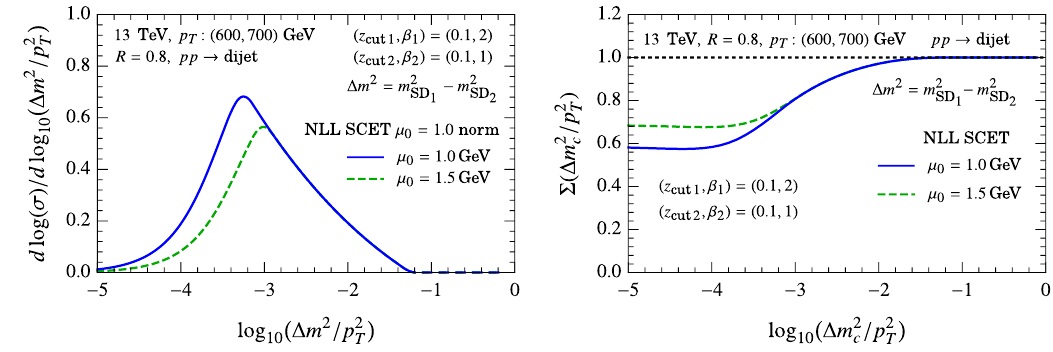
Figure 11 . Comparison of Collinear Drop distributions calculated using SCET with ( z cut1 ; (cid:12) 1 ) = (0 : 1 ; 2) and ( z cut2 ; (cid:12) 2 ) = (0 : 1 ; 1) and di(cid:11)erent cuto(cid:11) scale (cid:22) 0 of the running of strong coupling constant. The left panel shows the di(cid:11)erential distributions while the right panel shows the cumu- lant